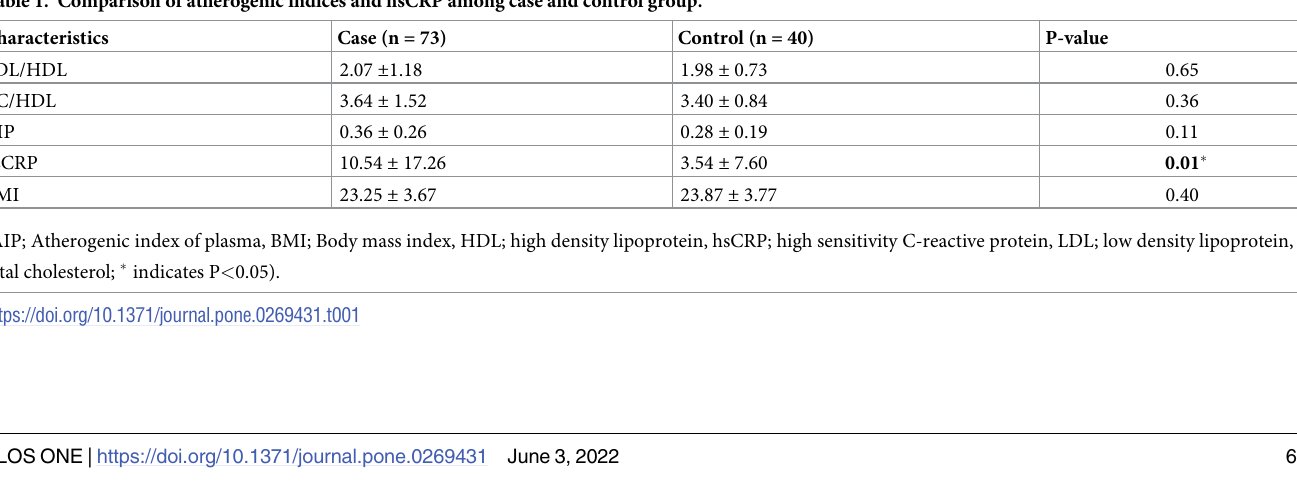
Table 1. Comparison of atherogenic indices and hsCRP among case and control group. Characteristics